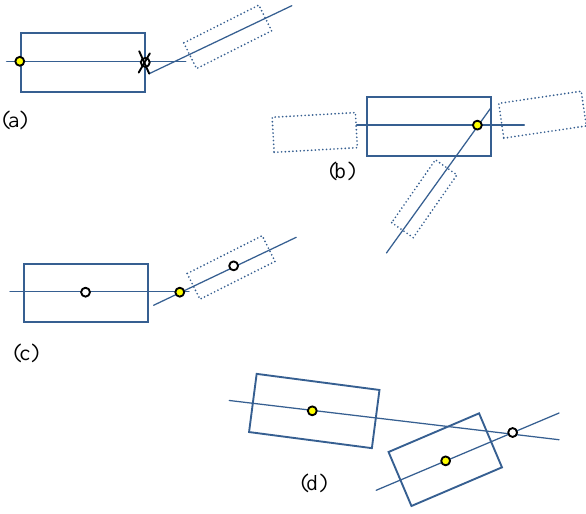
Figure 5. Different criteria define the choice of the nodes for the network graph (points filled in yellow are chosen).